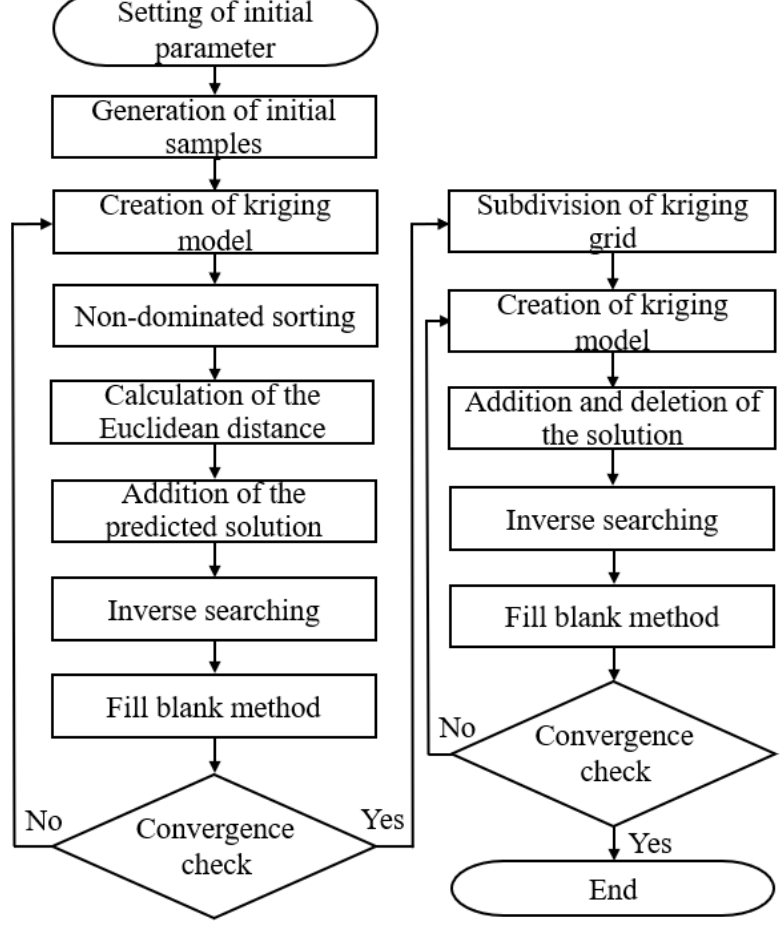
Figure 4. Flow chart of the SKMOO.